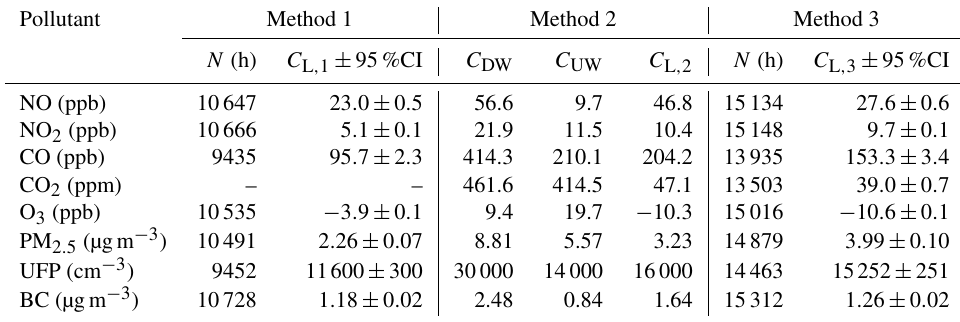
Table 4. Mean local pollutant concentrations at NR-VAN determined using each background-subtraction